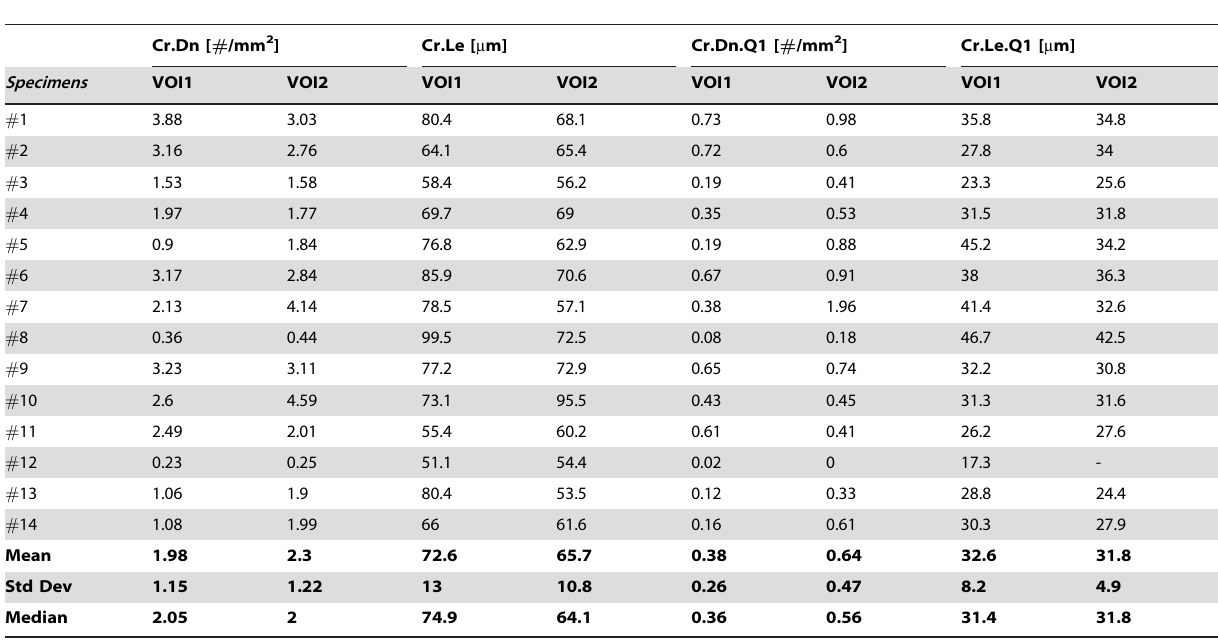
Table 2. Characteristics of microcracks embedded within the bone matrix in the control (VOI1) and fatigue-loaded (VOI2)